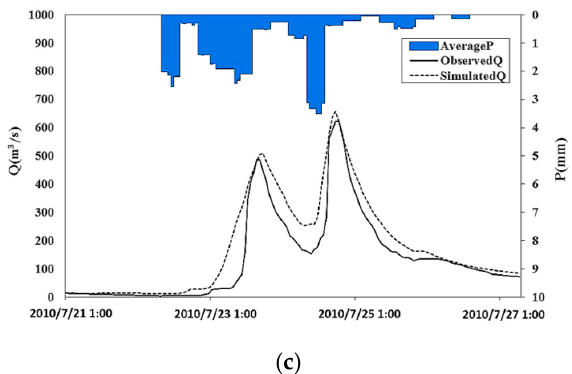
Figure 4. Simulated and observed hydrographs of the Chenhe Watershed. These examples illustrate the abilities of the Grid-Xinanjiang model (GXM) to complete hydrologic simulations. ( a ) 19 August–